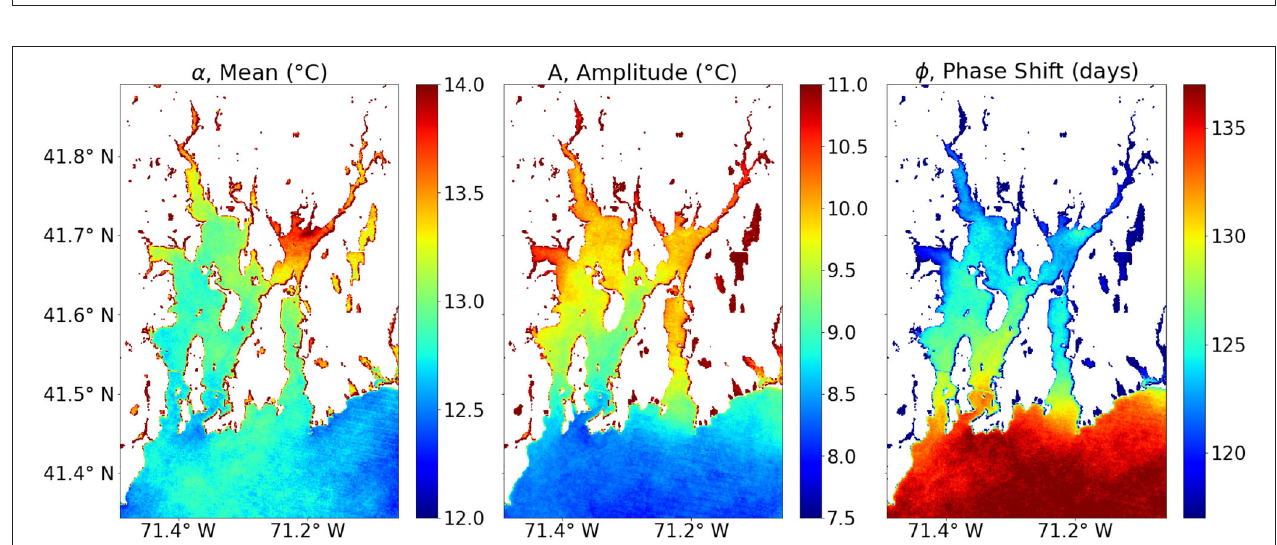
FIGURE 4 | Sample climatology for a pixel in Providence River after satellite bias correction.